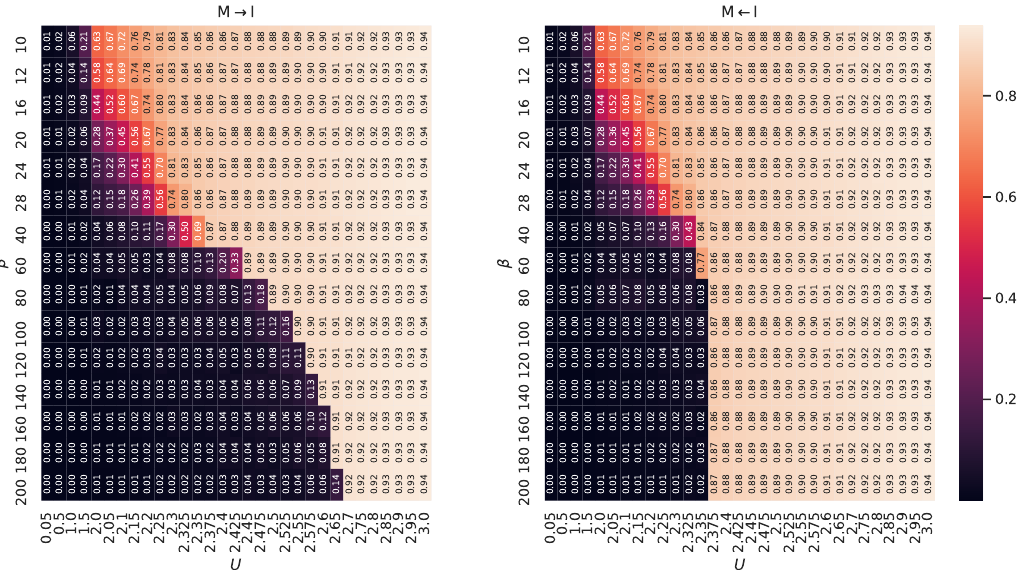
Figure 13: Comparison of U available values in the literature [ 29 ] Our error-bars give the distance to the next U − values for which a calculation was done.